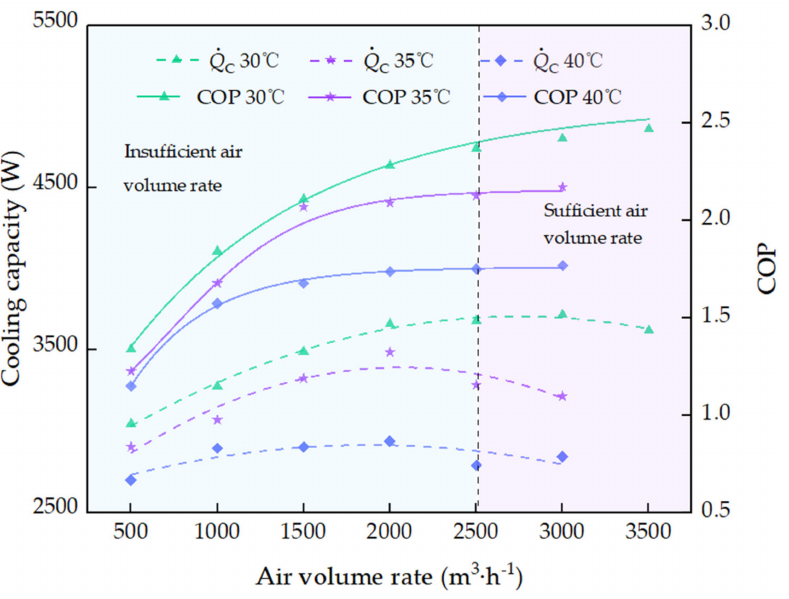
Figure 10. Influence of ambient temperature on the optimal gas cooler air volume flow